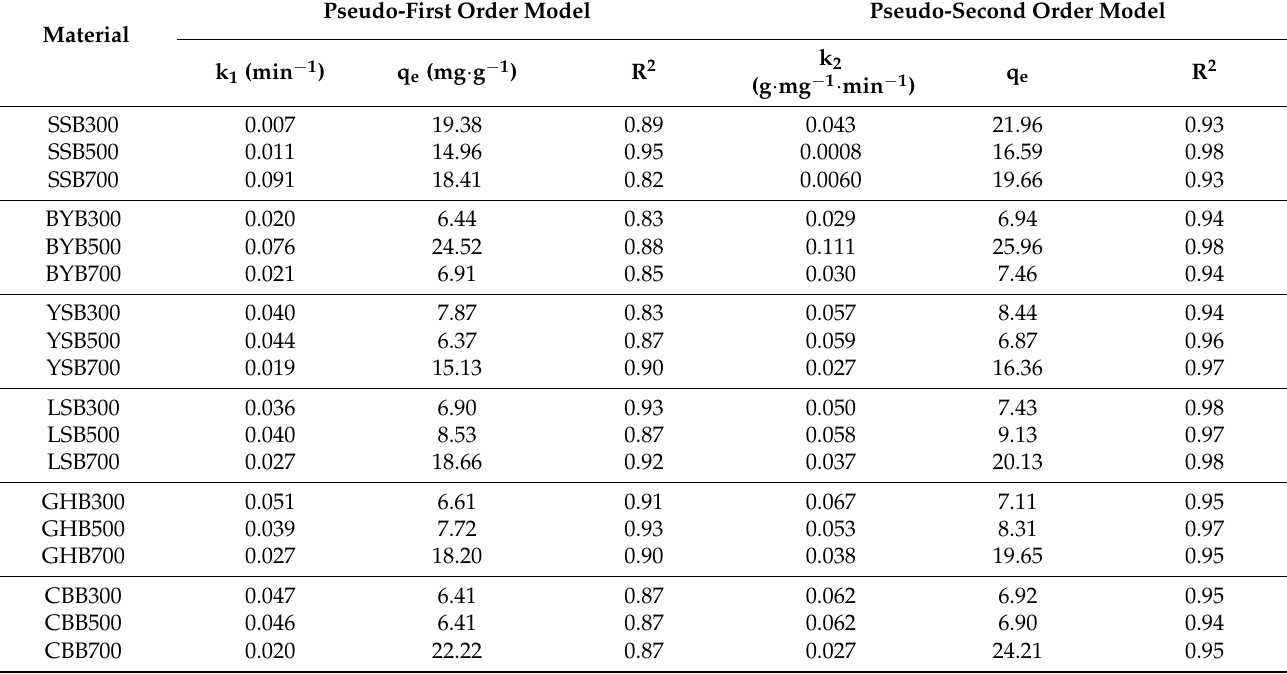
Table 2. Kinetic fitting